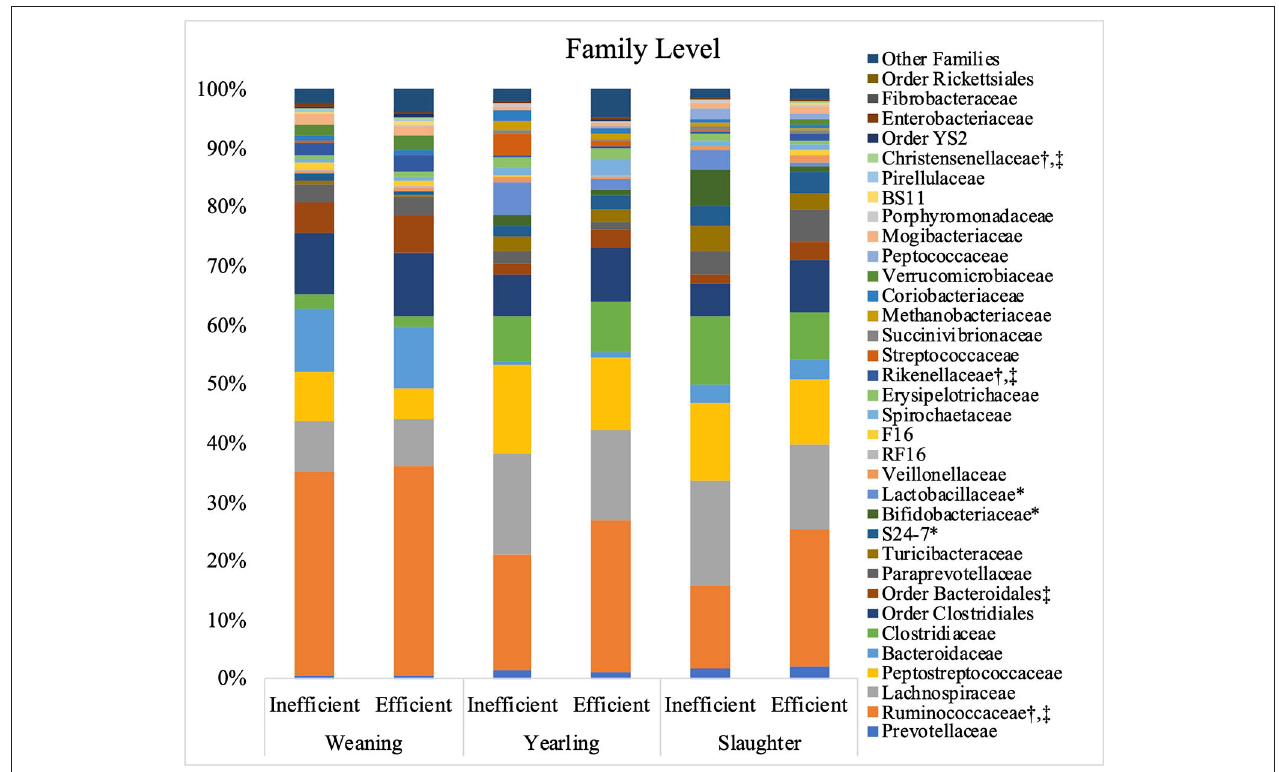
FIGURE 3 | Relative bacterial abundance at the family level found in the feces of efficient and inefficient steers at weaning, yearling, and slaughter. Differences between the two groups of steers ( P ≤ 0.05) are denoted by * at weaning, † at yearling, and ‡ at slaughter.